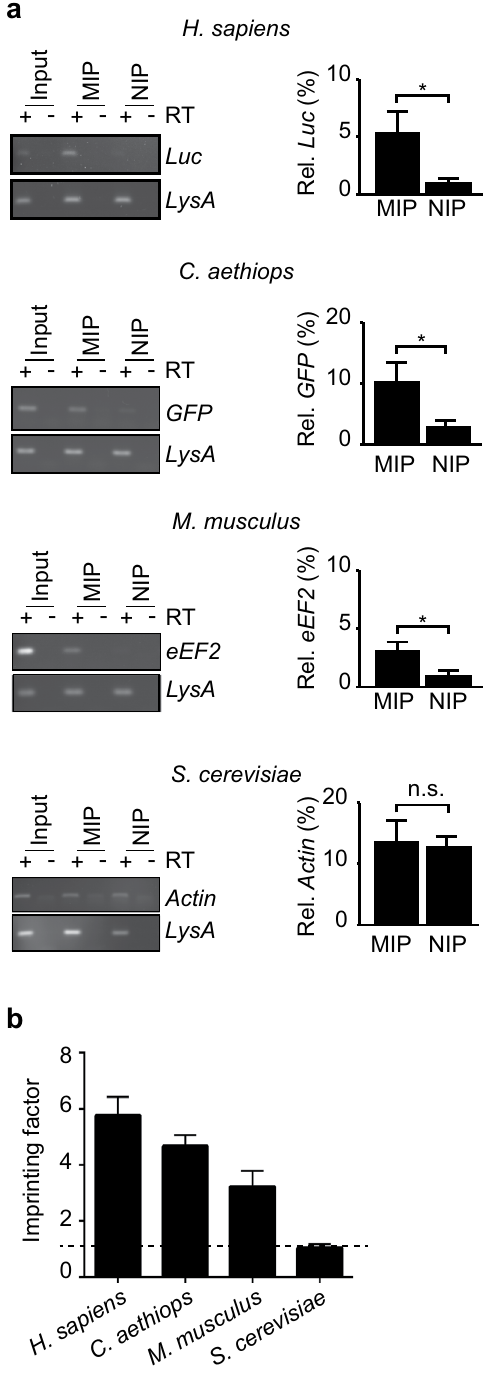
Figure 4. Human R-MIPs can be used to recover ribosome-associated mRNAs from cellular extracts of closely related eukaryotic species. ( a ) Detection of the indicated mRNAs from the specified species in extracts, MIPs and NIPs. RT-PCR products were visualised on agarose gels shown to the left. LysA is a spiked-in control used for normalisation. Images of uncropped gels and blots are shown in the Supplementary Fig. S1. The chart to the right shows relative recovery of indicated mRNAs with MIPs or NIPs as compared to the input extract (100%). RNA was quantified by RT-qPCR with the ΔΔ Ct method and normalised to LysA (see Methods). Standard error of means (SEM) are shown as bars; H. sapiens , n = 5, Luc reporter (pGL3) in HeLa cells; C. aethiops , n = 6, GFP reporter in VK219 cells; M. musculus , n = 5, endogenous eEF2 mRNA in C8-D1A cells; S. cerevisiae , n = 3, actin mRNA in yeast. * P < 0.05, two-tailed homoscedastic student’s t -test. ( b ) Imprinting factor (mean ± SEM) related to specified species ordered according to the evolutionary distance from human. The dotted line marks an IF of 1, indicating no preferential binding to MIP compared to